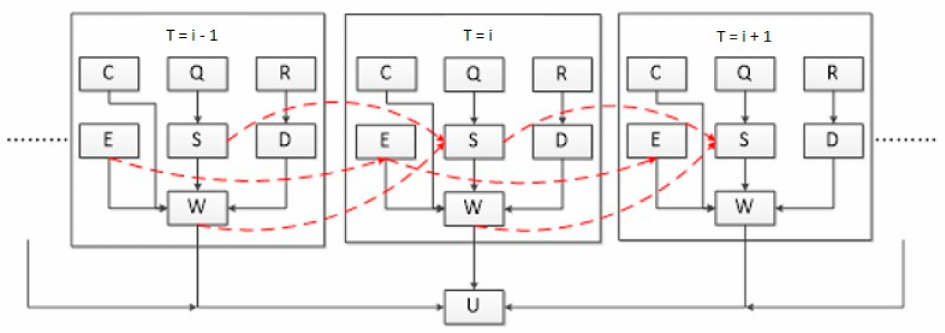
Figure 6. Structure diagram of